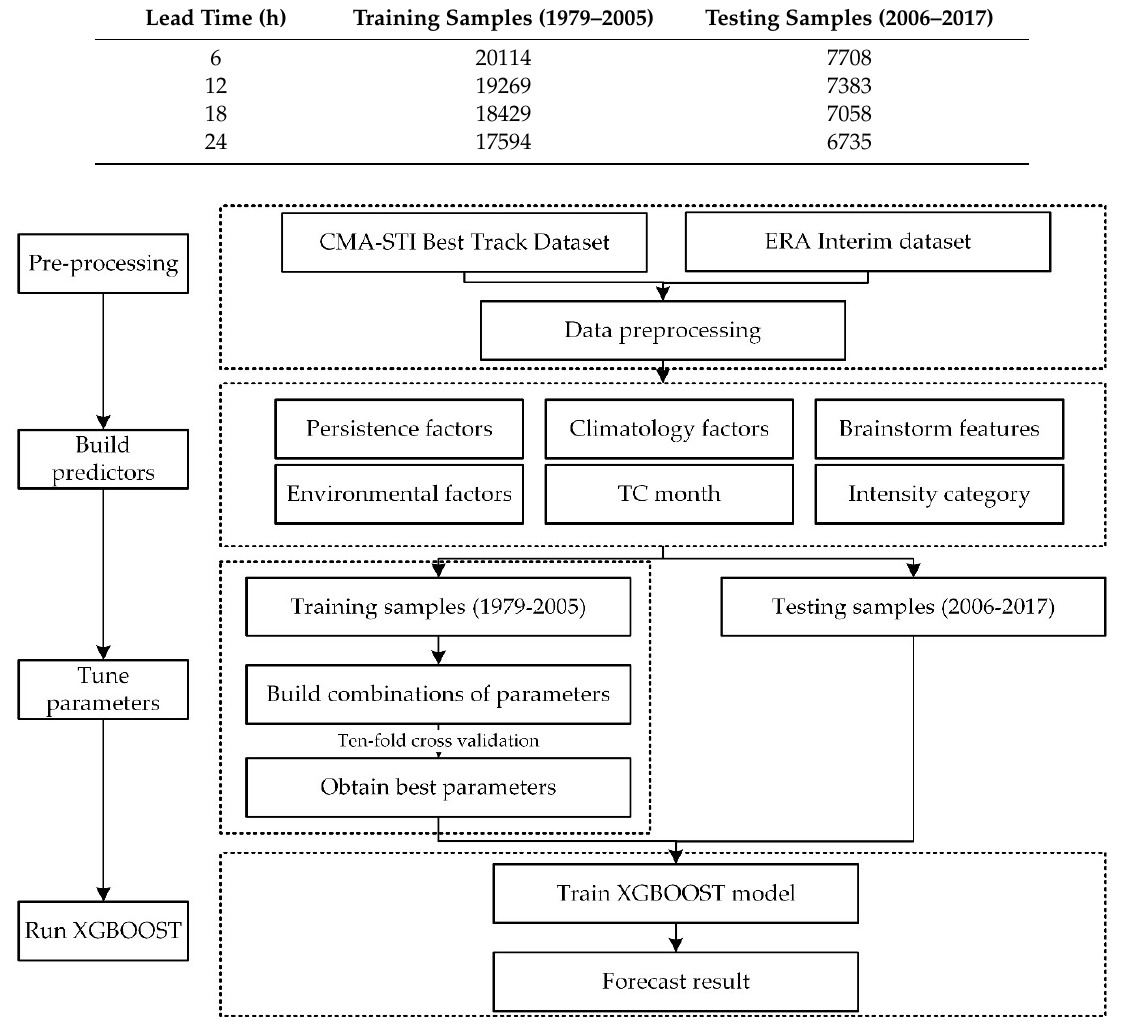
Table 1. Numbers of training samples and testing samples of TC intensity prediction experiment for 1979–2017 over the WNP.